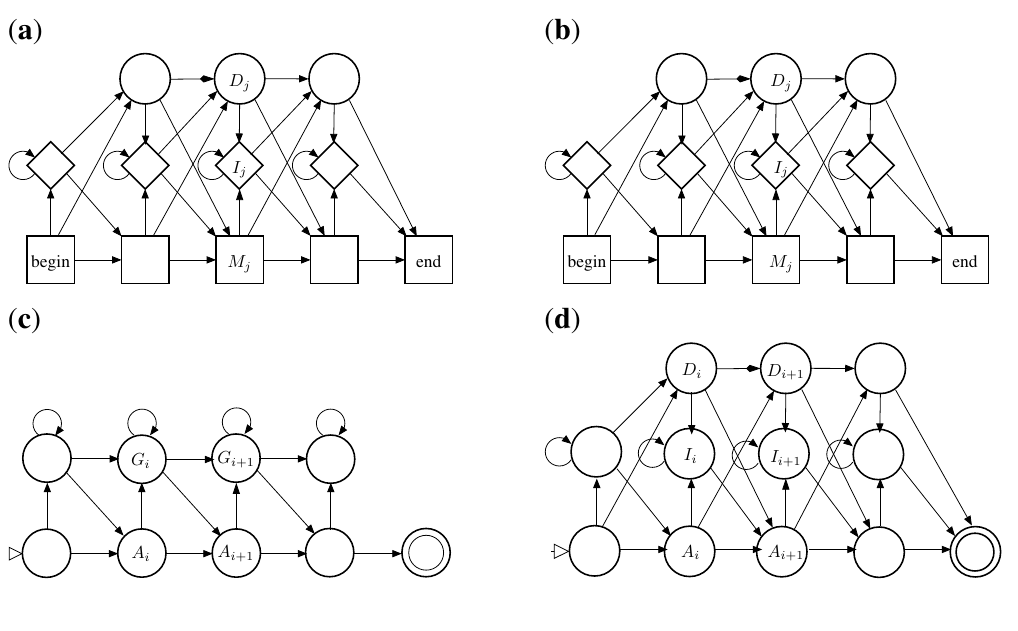
( a ) Graphical representation of a profile HMM (left, source: [20], Figure 5.2.); ( b ) dependency graph for grammar M ATCH A FFI S; ( c ) for M ATCH O SCI S; and ( d ) M ATCH T RACE